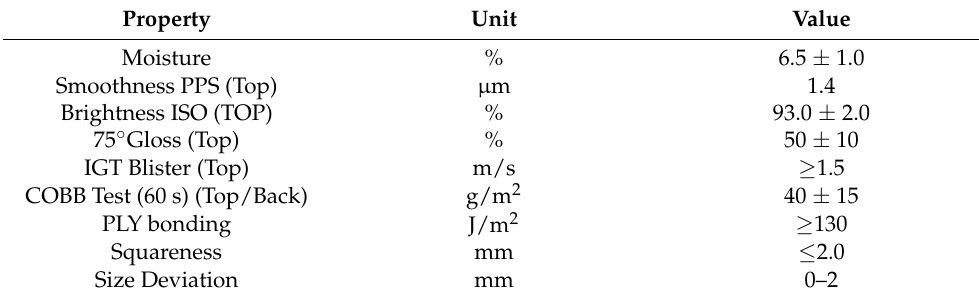
Table 1. Paperboard technical information.